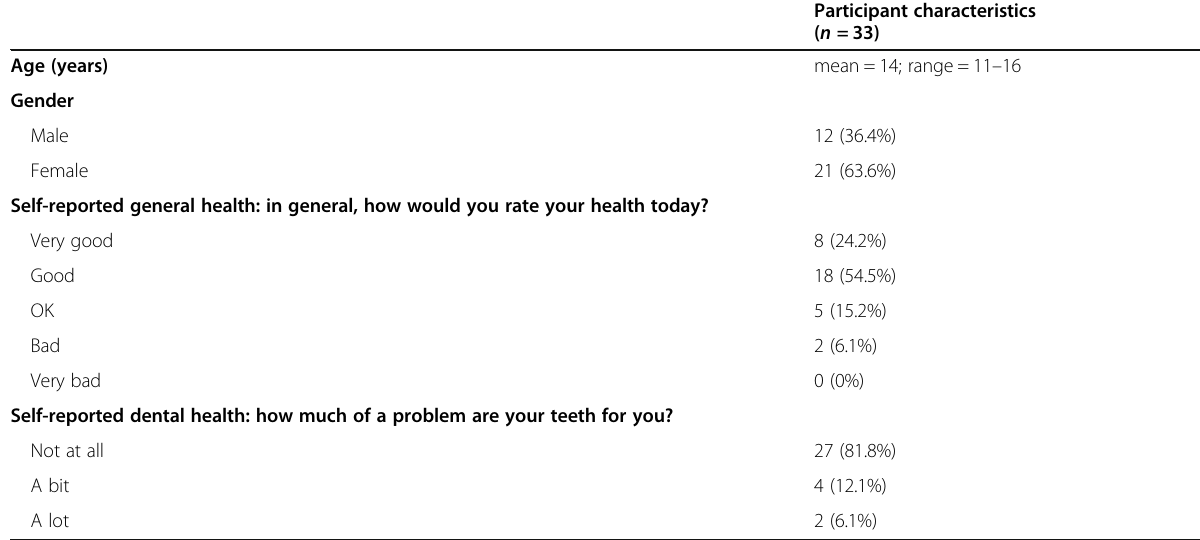
Table 2 Summary of participant